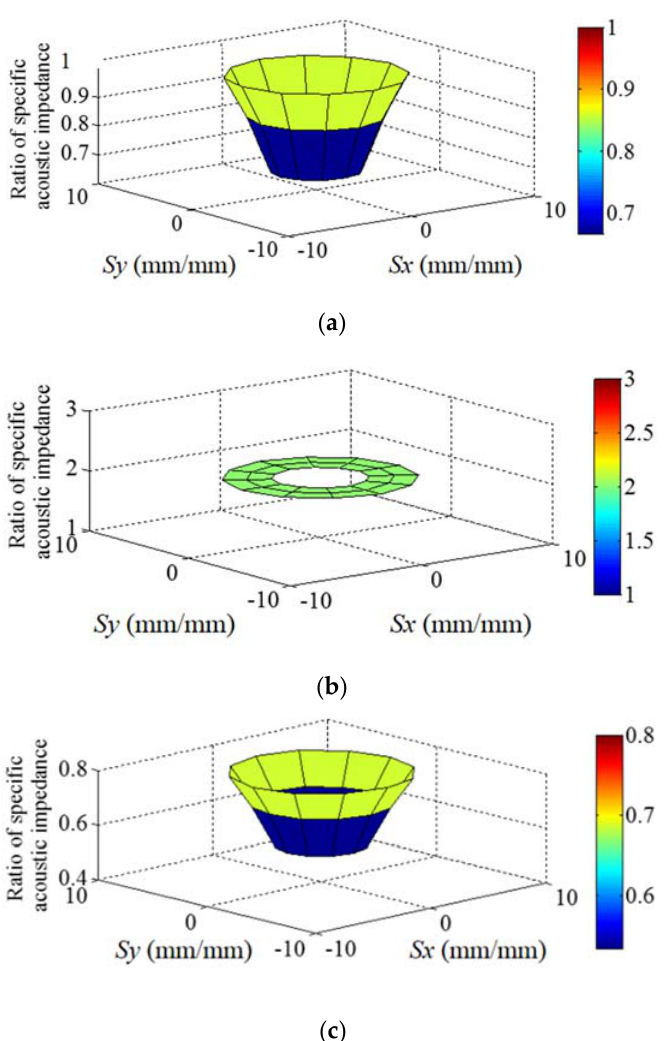
Figure 3. The required ratio of specific acoustic impedance value z shell of the cloak shell (relative to the background specific acoustic impedance value): ( a ) cloak shell region in e u direction; ( b ) in the e v direction; ( c ) in the e w direction.